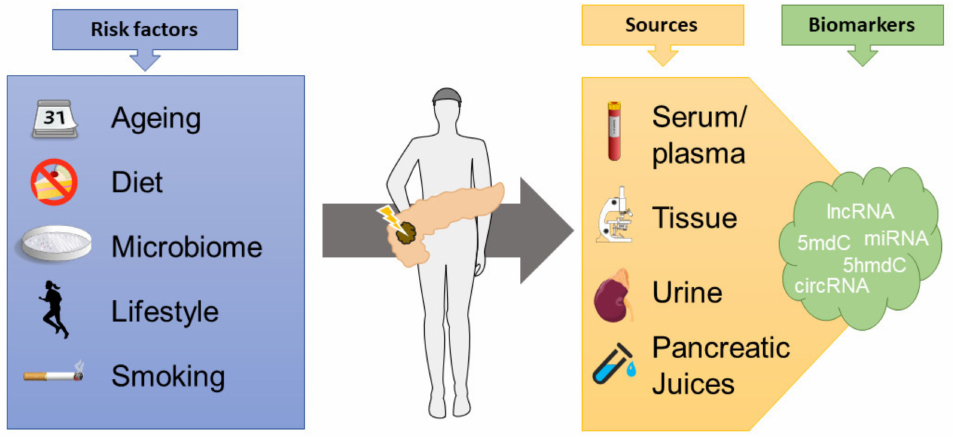
Figure 2. Several modifiable and non-modifiable factors influence the epigenome in cancers,